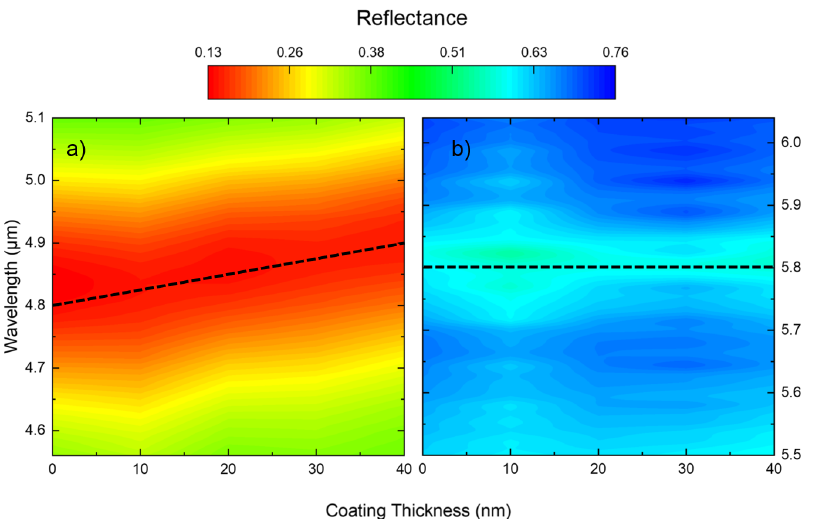
Figure 5. False-color map of the reflectance of the reciprocal plasmonic metasurface as a function of the coating thickness and wavelength centered on the plasmonic metasurface resonance ( a ) and the IP-Dip absorption band ( b ), respectively. Whereas a shift of the center absorption wavelength as a function of dielectric coating thickness can be easily observed in ( a ), the IP-Dip absorption band shown in ( b ) is not affected, as